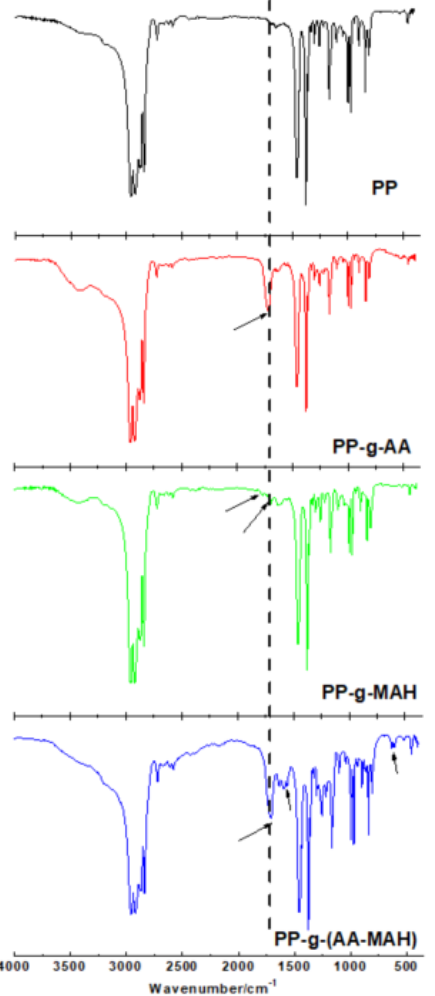
Figure 7. FTIR spectra of PP, PP-g-AA, PP-g-MAH and PP-g-(AA-MAH) fibers.